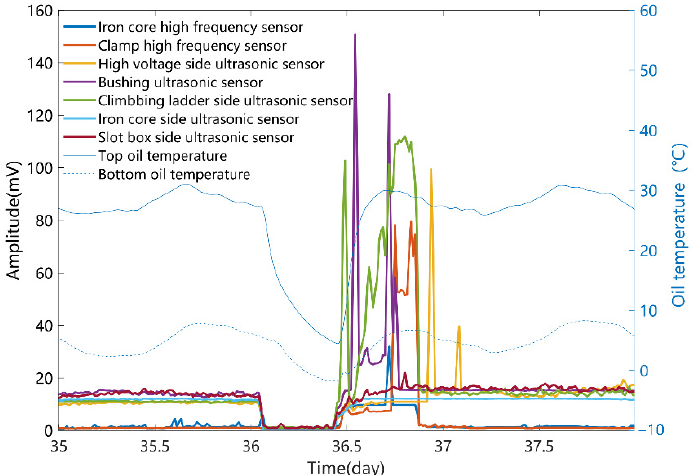
Figure 5. Measurement results of pulse current, oil temperature and ultrasonic signal of reactor in the 35th to 38th days.